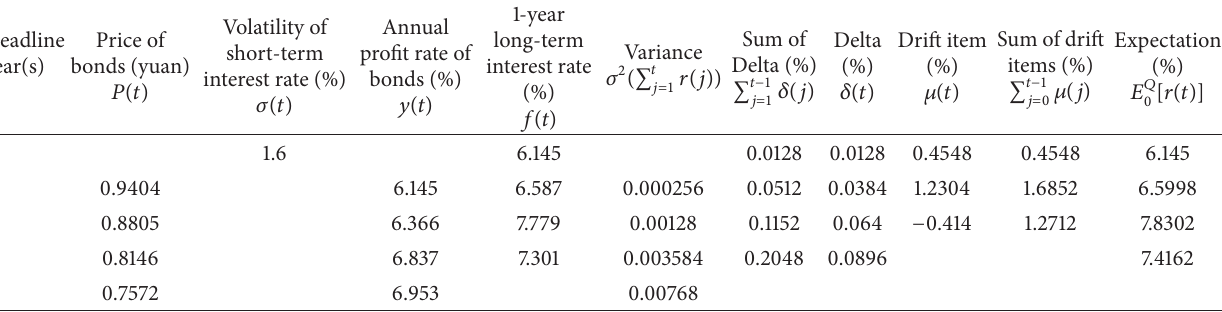
Table 1: Constant volatility interest rate parameters.